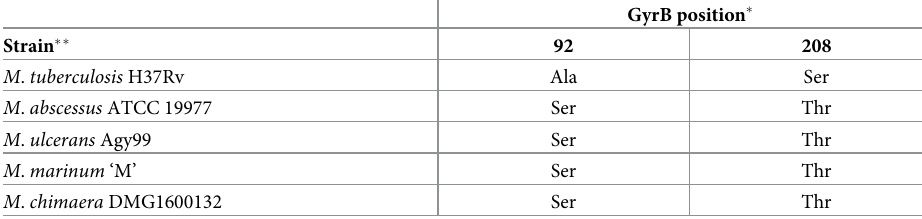
Table 4. Amino acid residues at GyrB positions associated with SPR719 non-susceptibility. Strain